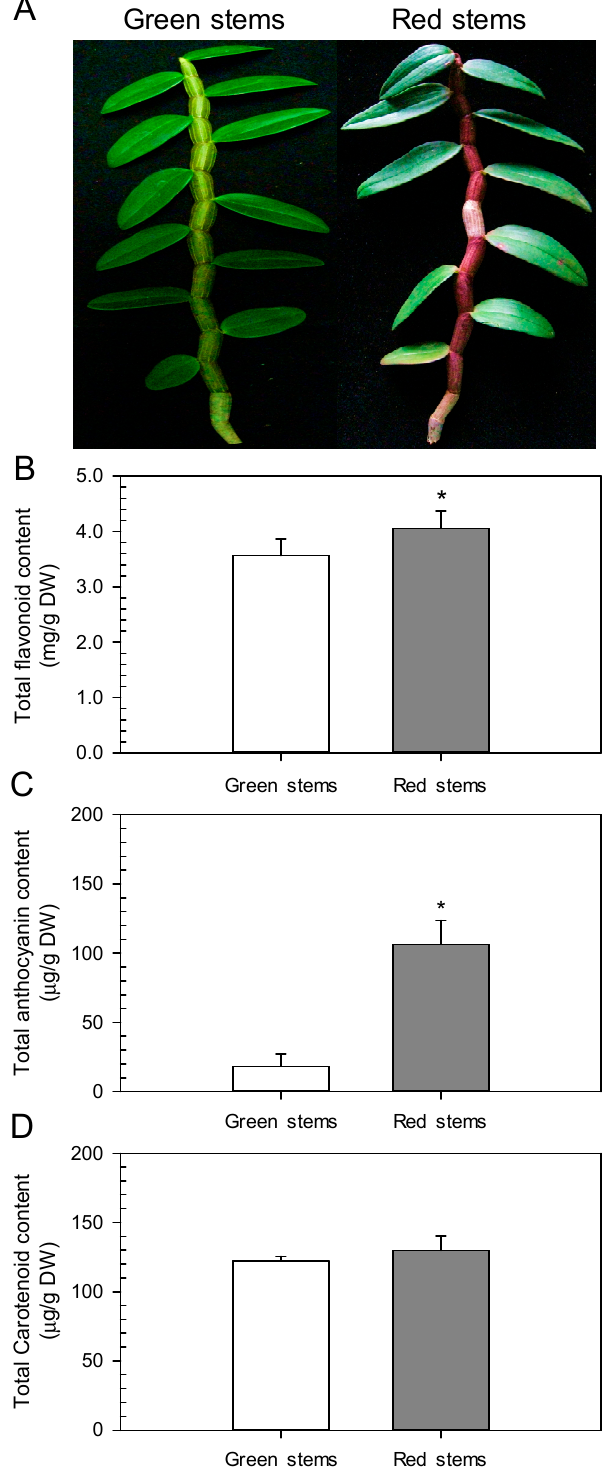
Figure 2. Photographs and pigment contents of D. officinale stems. ( A ) photographs of green stems of ‘T32-5 ′ and red stems of ‘T32-4 ′ ; ( B ) total flavonoid content in red and green stems; ( C ) total anthocyanin content in red and green stems; ( D ) total carotenoid content in red and green stems. Each data bar represents the mean ± SD ( n = 3). Asterisks indicate significant differences between red and green stems according to a student’s t -test ( p < 0.05). DW, dry weight.